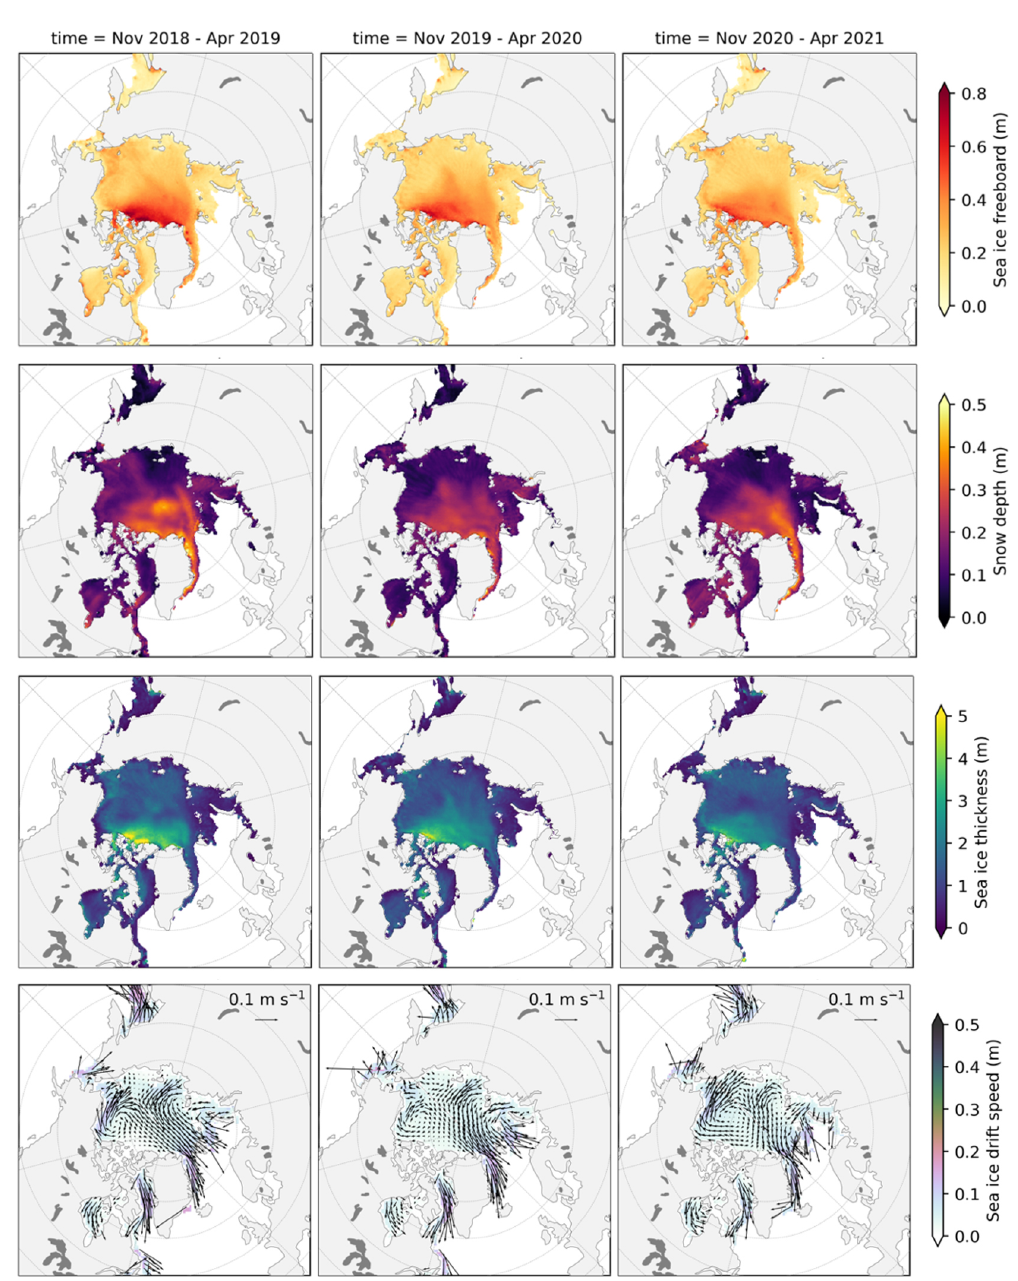
Figure 13. Winter (November to April) mean ICESat-2 freeboard (top) redistributed NESOSIM v1.1 snow depth (second row), sea ice thickness (third row) and OSI SAF sea ice drifts (bottom row) for the 2018–2019 (left column), 2019–2020 (middle column) and 2020–2021 (right column) winters based on the monthly gridded IS2SITMOGR4 v2 data (using the interpolated/smoothed variables for each